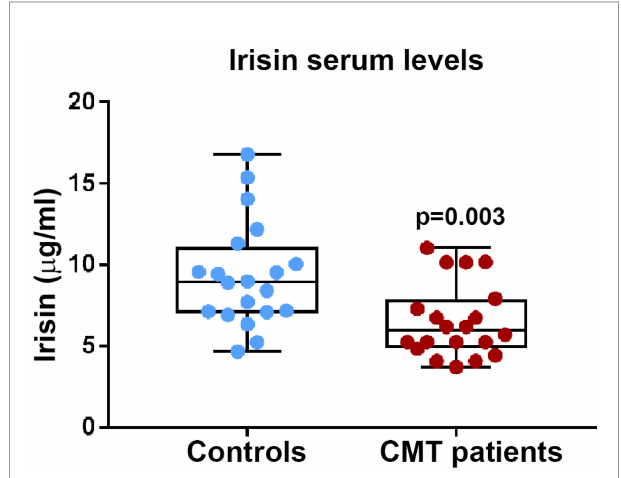
FIGURE 1 | Irisin serum levels are signi fi cantly lower in CMT patients (N = 20) compared to healthy matched controls (N = 20); p values as indicated.